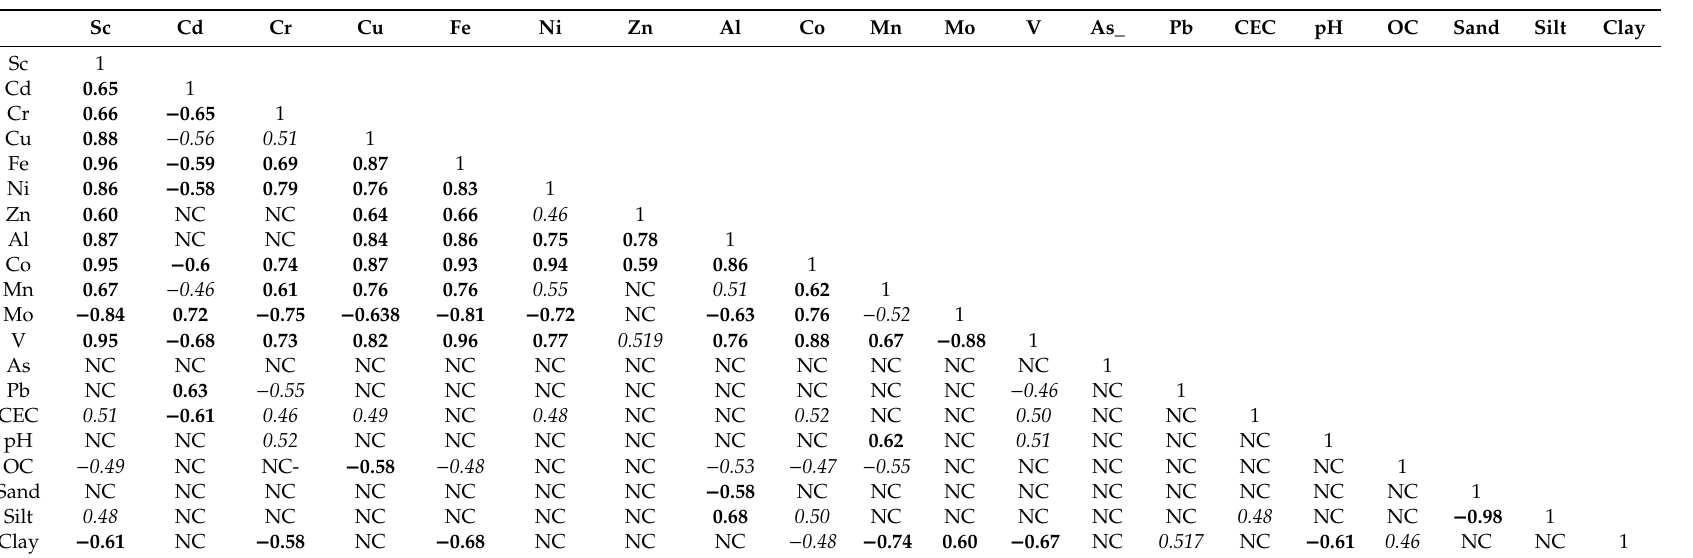
Table 4. Pearson’s correlation analysis of PTE in agricultural